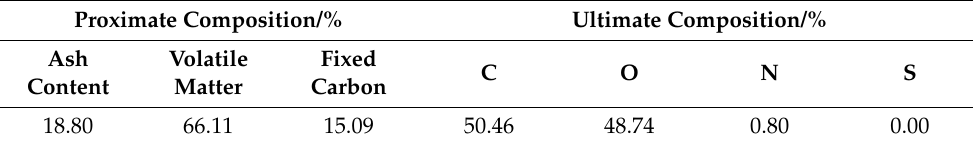
Table 3. Proximate and ultimate composition analysis of biochar.